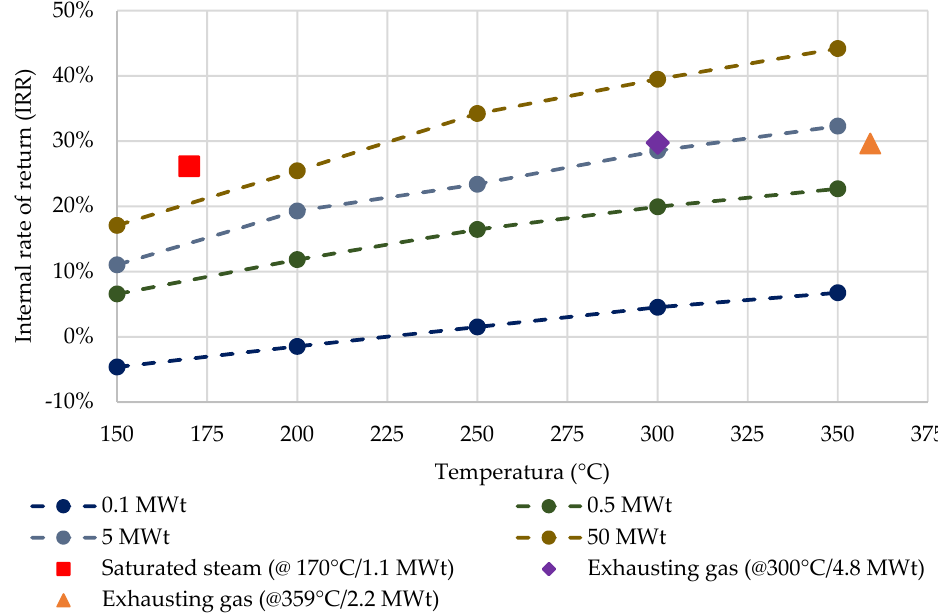
Figure 4. The optimized IRR values.